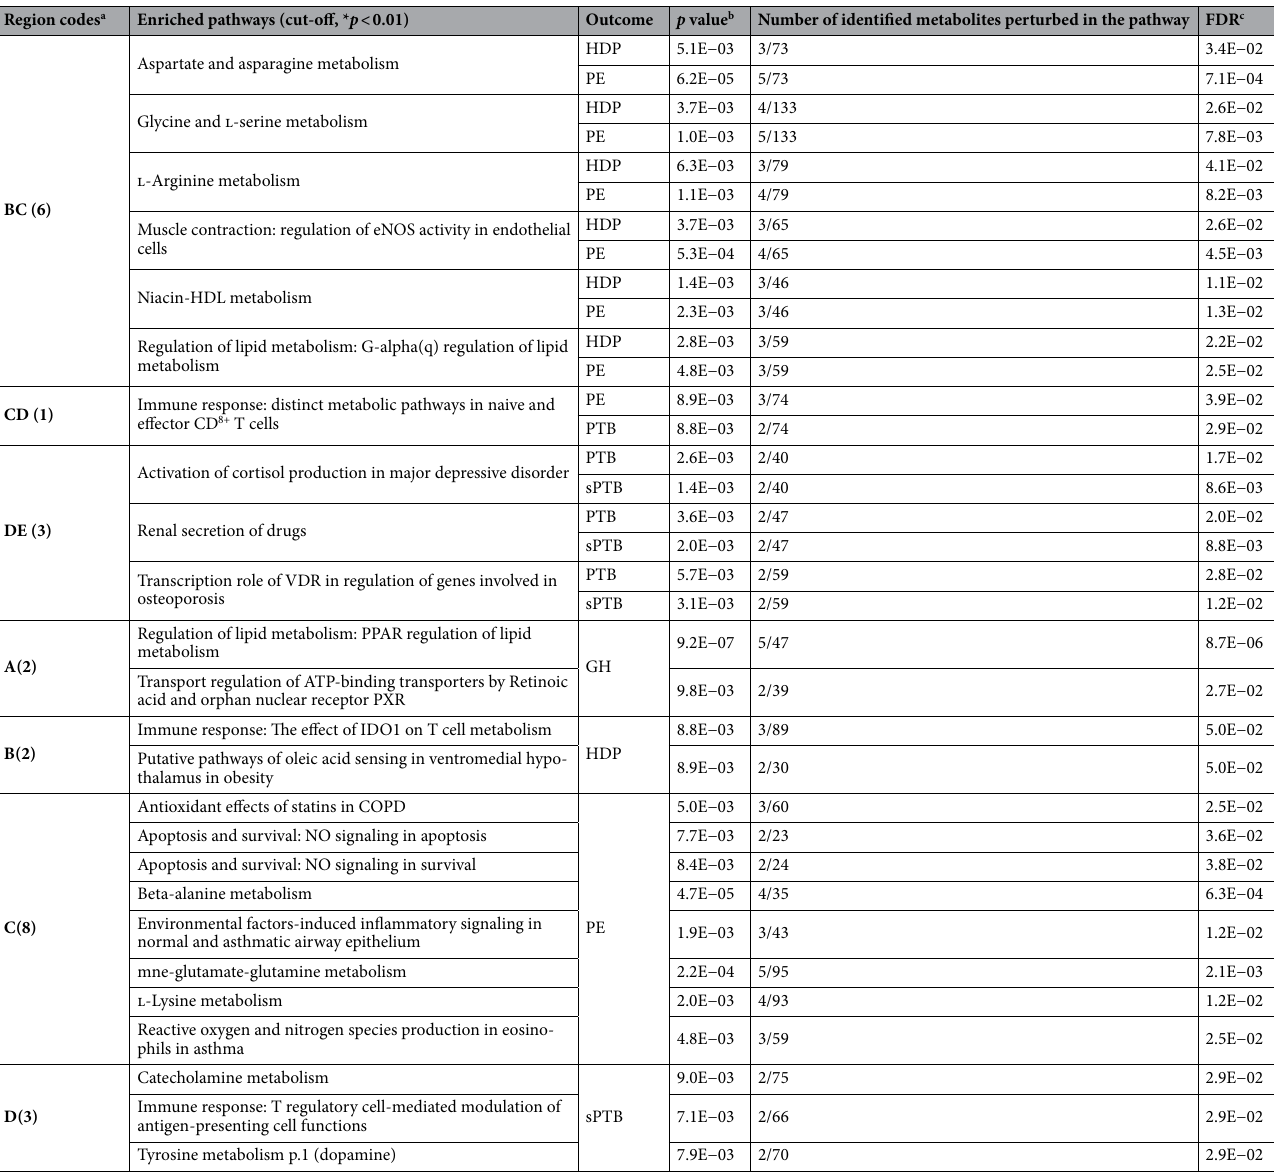
Table 5. Enriched metabolic pathways perturbed between different case groups and control group (corresponding to Fig. 1). Metabolic pathways between cases (e.g., GH, HDP, PE, PTB, and sPTB) and controls were enriched by GeneGo MetaCore using Enrichment by Pathway Maps. a Capital letters (A, B, C, D, E, and their combinations) and numbers are corresponding to the Venn diagram in Fig. 1. Pathways in a region with single capital letter are specific to a certain phenotype; while pathways in a region with combination of letters indicate the common pathways being impacted in different phenotypes. A, gestational hypertension (GH); B, hypertensive disorder of pregnancy (HDP); C, pre-eclampsia (PE); D, preterm birth (PTB); E, spontaneous preterm birth (sPTB). b The p value that was generated from the hypergeometric test in Metacore indicates the significance of enrichment of metabolites in pathway mapping. A lower p value indicates a higher significance in the pathway enrichment. c FDR = false discovery